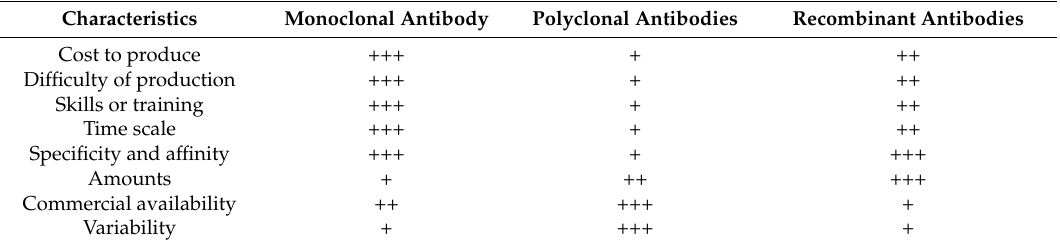
Table 1. Comparison of parameters for producing monoclonal, polyclonal, and recombinant antibodies.